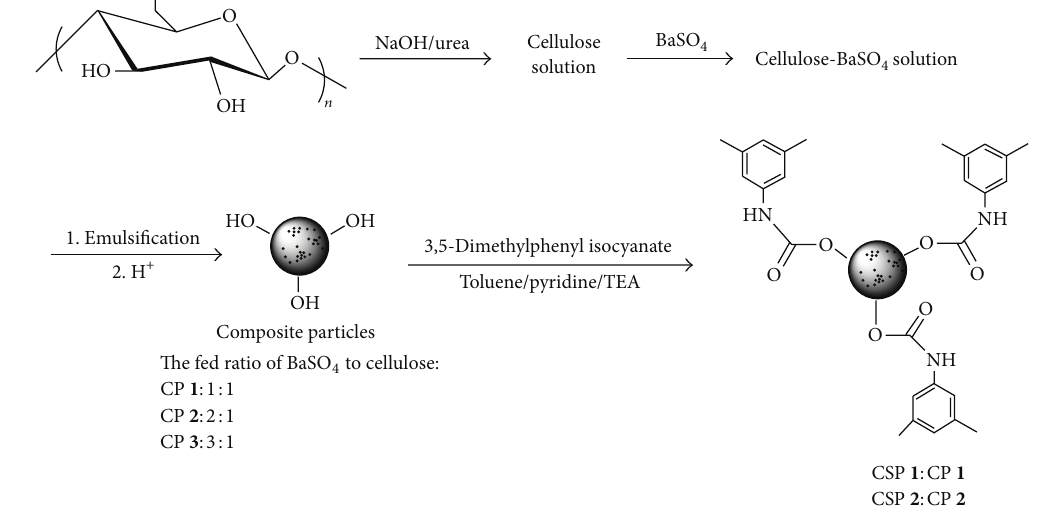
Figure 1: The preparation scheme of the composite particles and the CSPs.